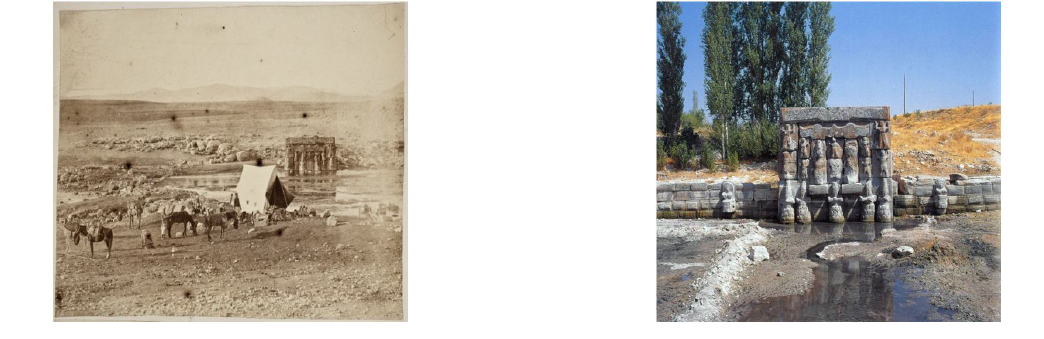
Picture 5: Eflatunpinar/ Hitit Monument (1909) Picture 6: Eflatunpinar/ Hitit Monument